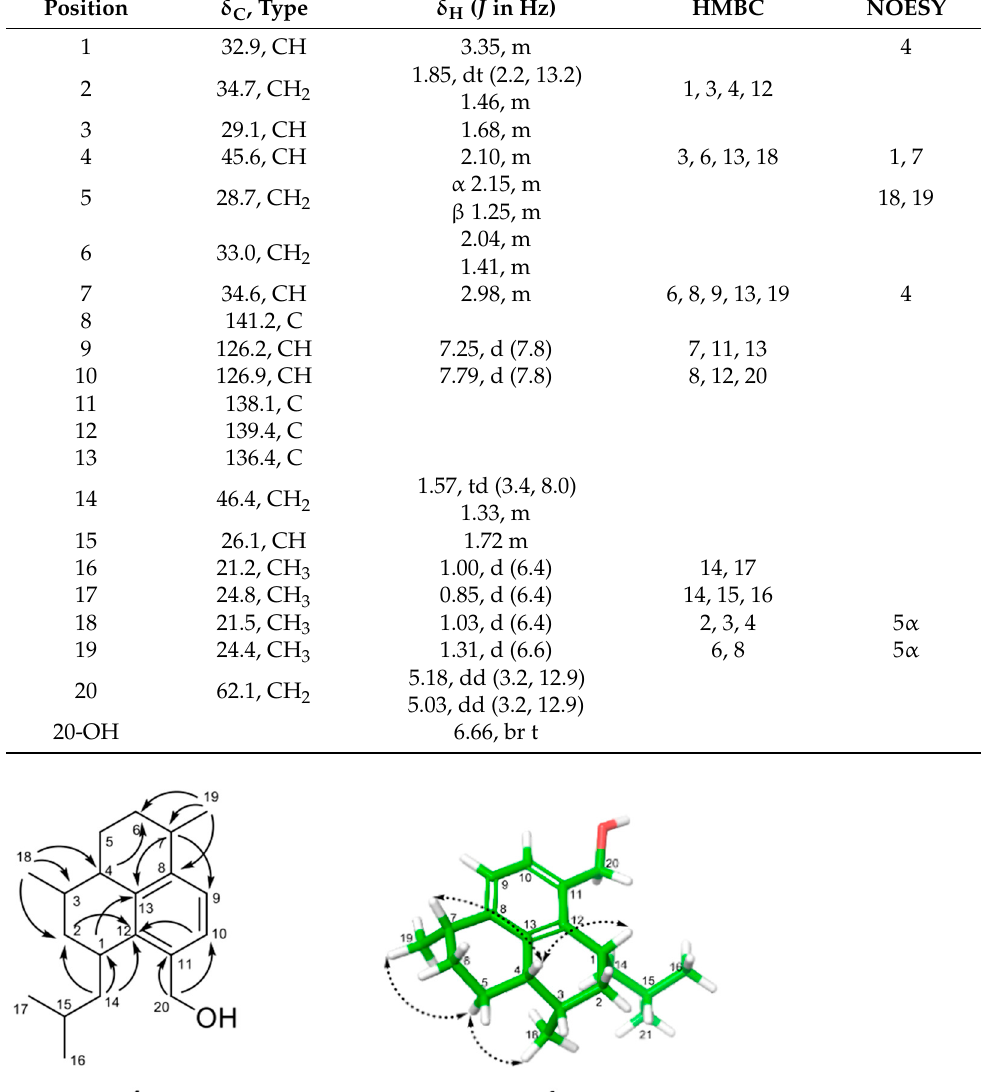
Table 1. NMR spectroscopic data (400 MHz, pyridine- d 5 ) for Compound 1 .